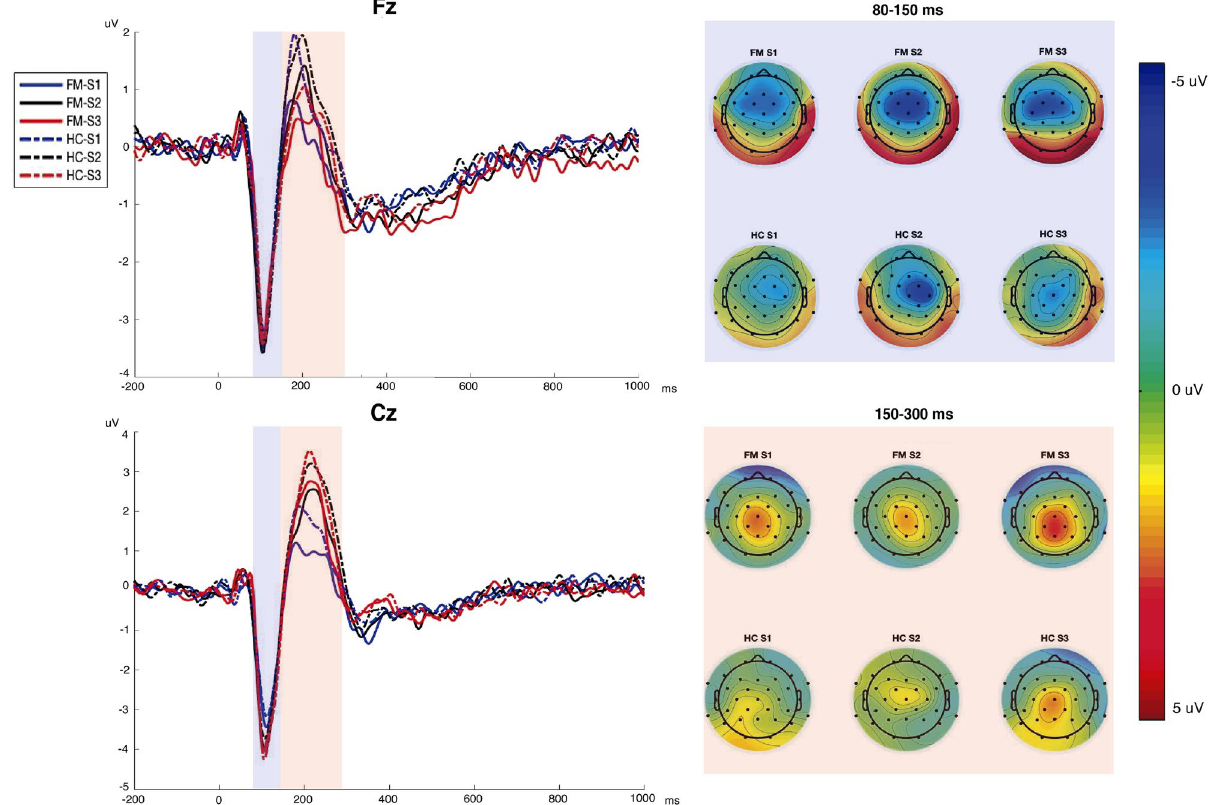
Figure 3. Right. Auditory evoked potentials (AEPs) at electrodes Fz and Cz elicited by the tones of 70 dB (S1; blue line), 90 dB (S2; black line) and, 105 dB (S3; red line) in patients with fibromyalgia (FM) and healthy controls (HC). Left. Scalp distribution of AEP amplitudes elicited by the three stimuli. The upper part shows the topography of N1 (measured as the mean value from 80 to 150 ms), and the lower part shows the topography of P2 (measured from 150 to 300